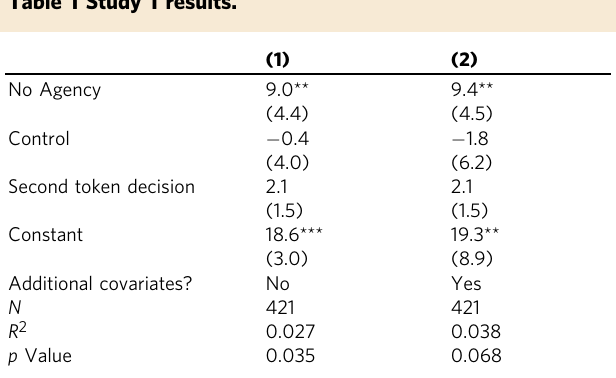
Table 1 Study 1 results.